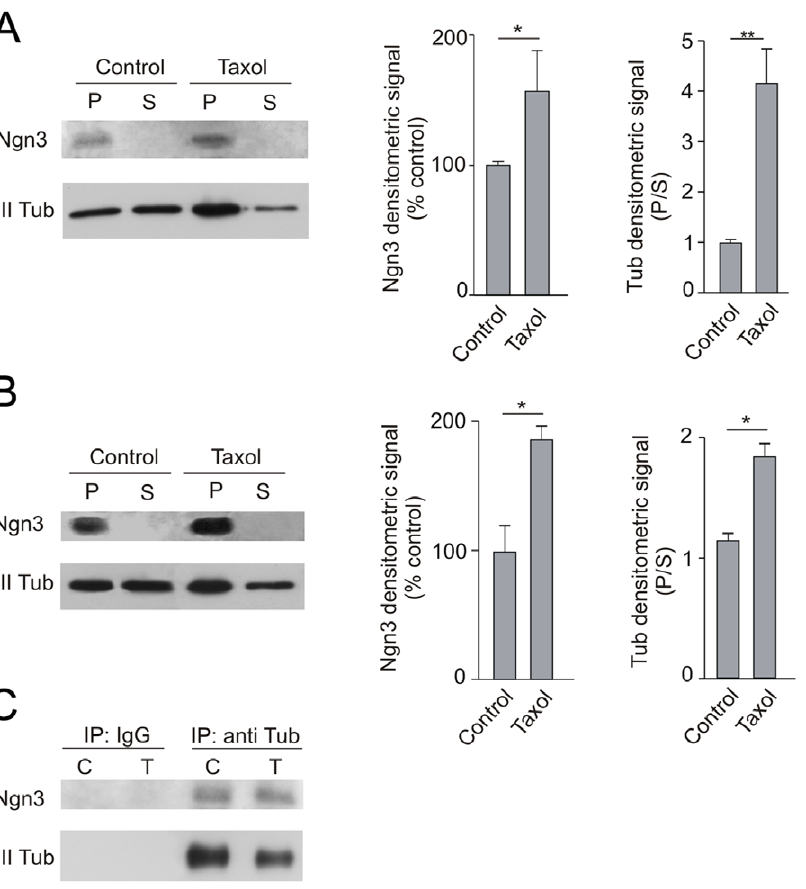
Figure 7. Pharmacological perturbation of the cytoskeleton suggests association of Ngn3 to tubulin and microtubules. ( A ) Cultured neurons were untreated or treated with paclitaxel (Taxol; 20 m M) for 40 minutes; then cells were lysated and centrifuged. Proteins present in the precipitate, that includes microtubules and associated proteins (P) and supernatant (S) were analyzed by Western blotting. Ngn3 is enriched in the insoluble fractions and its concentration increases as polymerized tubulin does. ( B ) Embryonic mouse brains were homogenized and a high-speed precipitate was resuspended and divided in two. Aliquots were left untreated or treated with 20 m M paclitaxel plus 1 mM GTP for 40 minutes at room temperature. Microtubular fraction sedimented by centrifugation (P) and supernatant (S) were analyzed by Western blotting. ( C ) The supernatants (S) of control (C) and paclitaxel (T) treated aliquots were immunoprecipitated (IP) with anti- b III-tubulin antibody (or IgG control) to determine the interaction of Ngn3 with soluble tubulin. Precipitates were analyzed by Western blotting with anti-Ngn3 antibody. Graphs show the quantification of densitometry. Error bars show the mean + s.e.m. of three experiments. Significance levels were determined for the data sets connected by horizontal lines using the Student’s t-test. * p , 0.05, **p ,